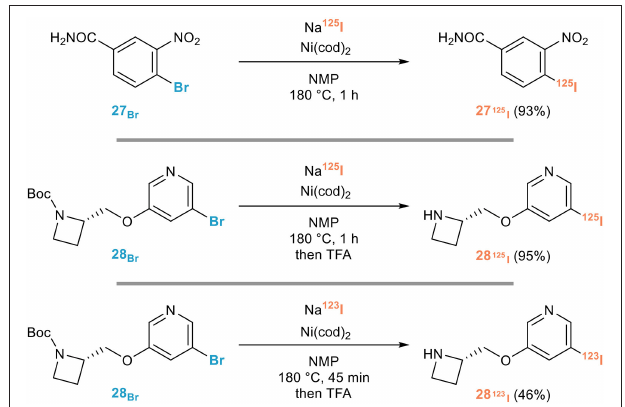
FIGURE 15 | Representative applications of the aromatic Finkelstein reaction for radioiodination.